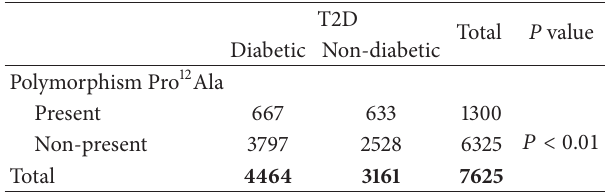
Table 6: Pro 12 Ala polymorphism and T2D.